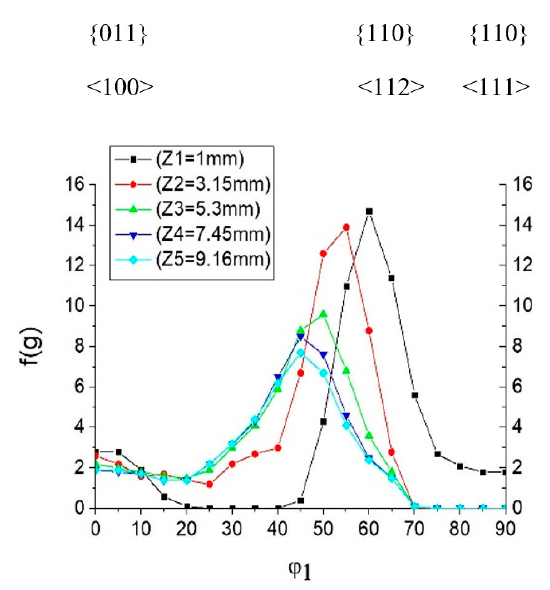
Figure 8. The α -fiber plot of Z1 to Z5.